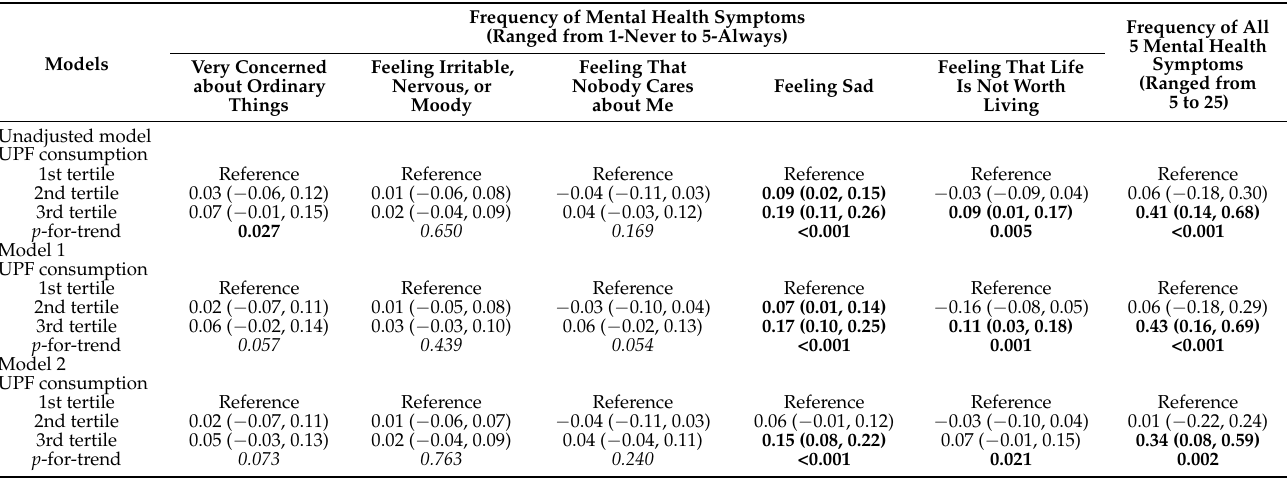
Table 3. Association * between ultra-processed food consumption and mental health symptoms in adolescent student boys aged 13–17 years, Brazil,